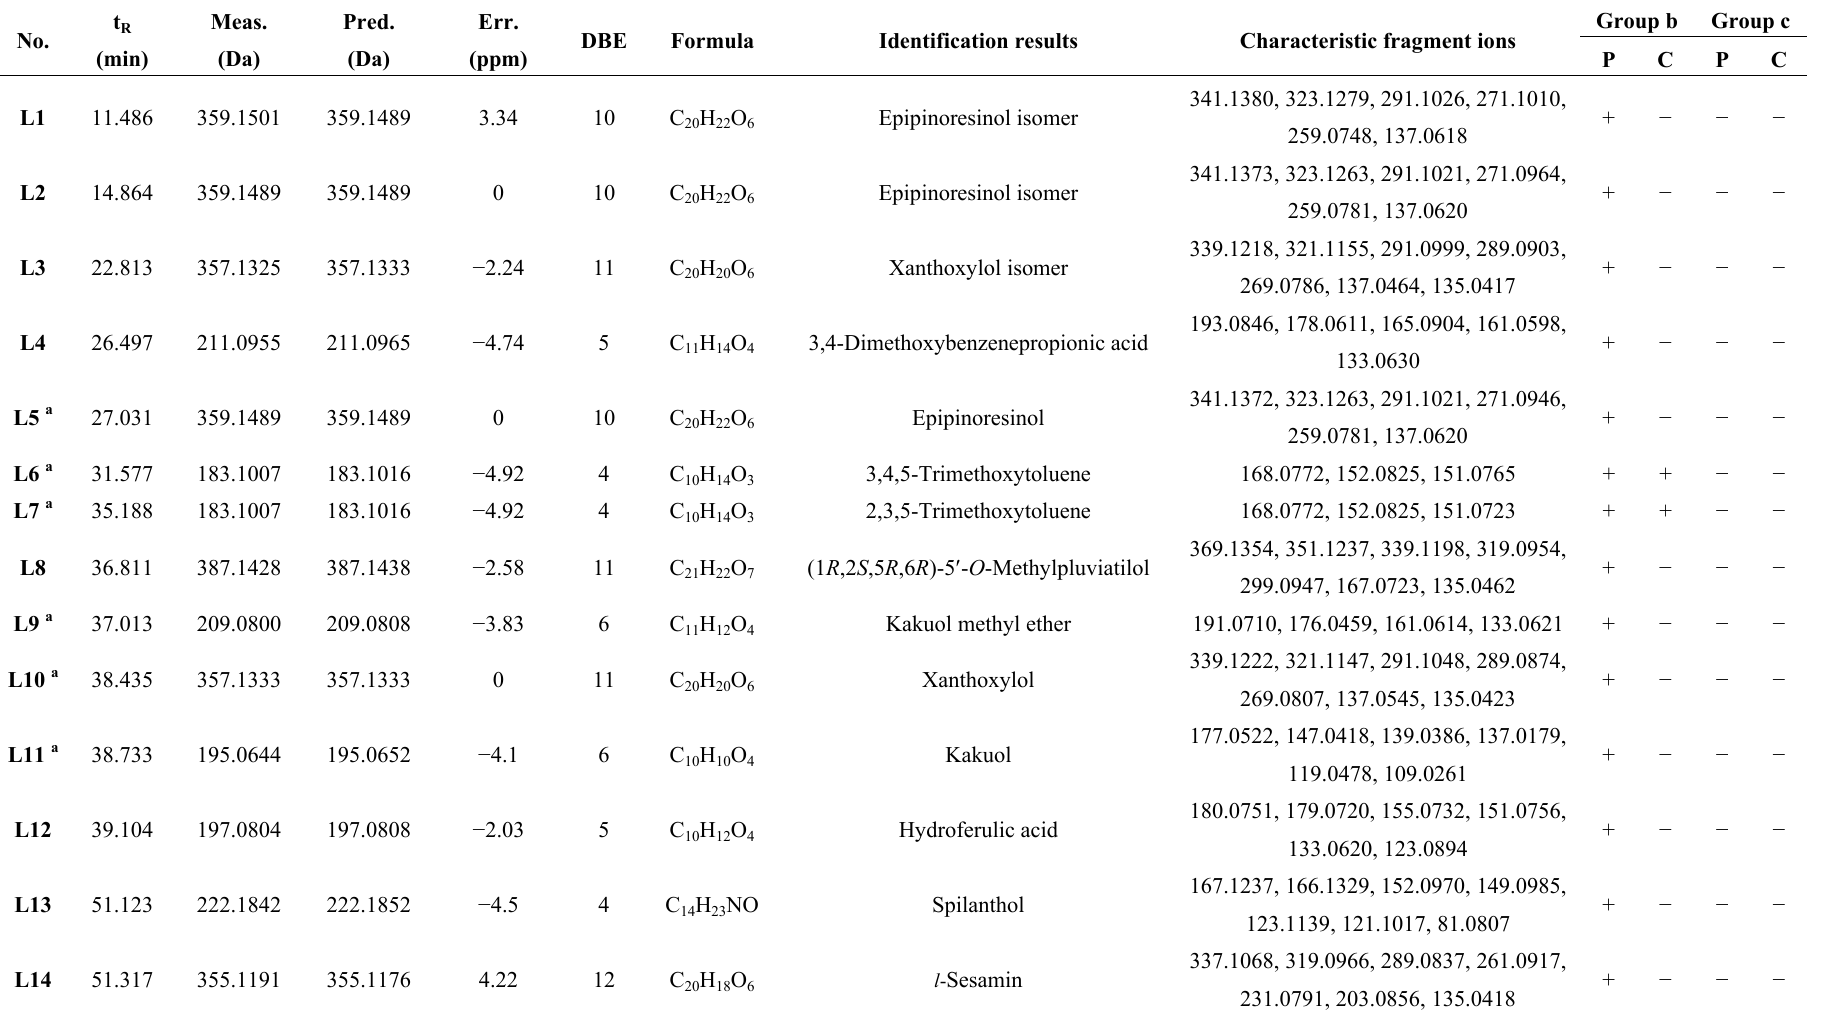
Table 2. The absorbed constituents in rabbit plasma and CSF from AR EtOAc extract group (group b ) and AR powder group (group c ) identified by HPLC-APCI-IT-TOF-MS n . Identification results Characteristic fragment